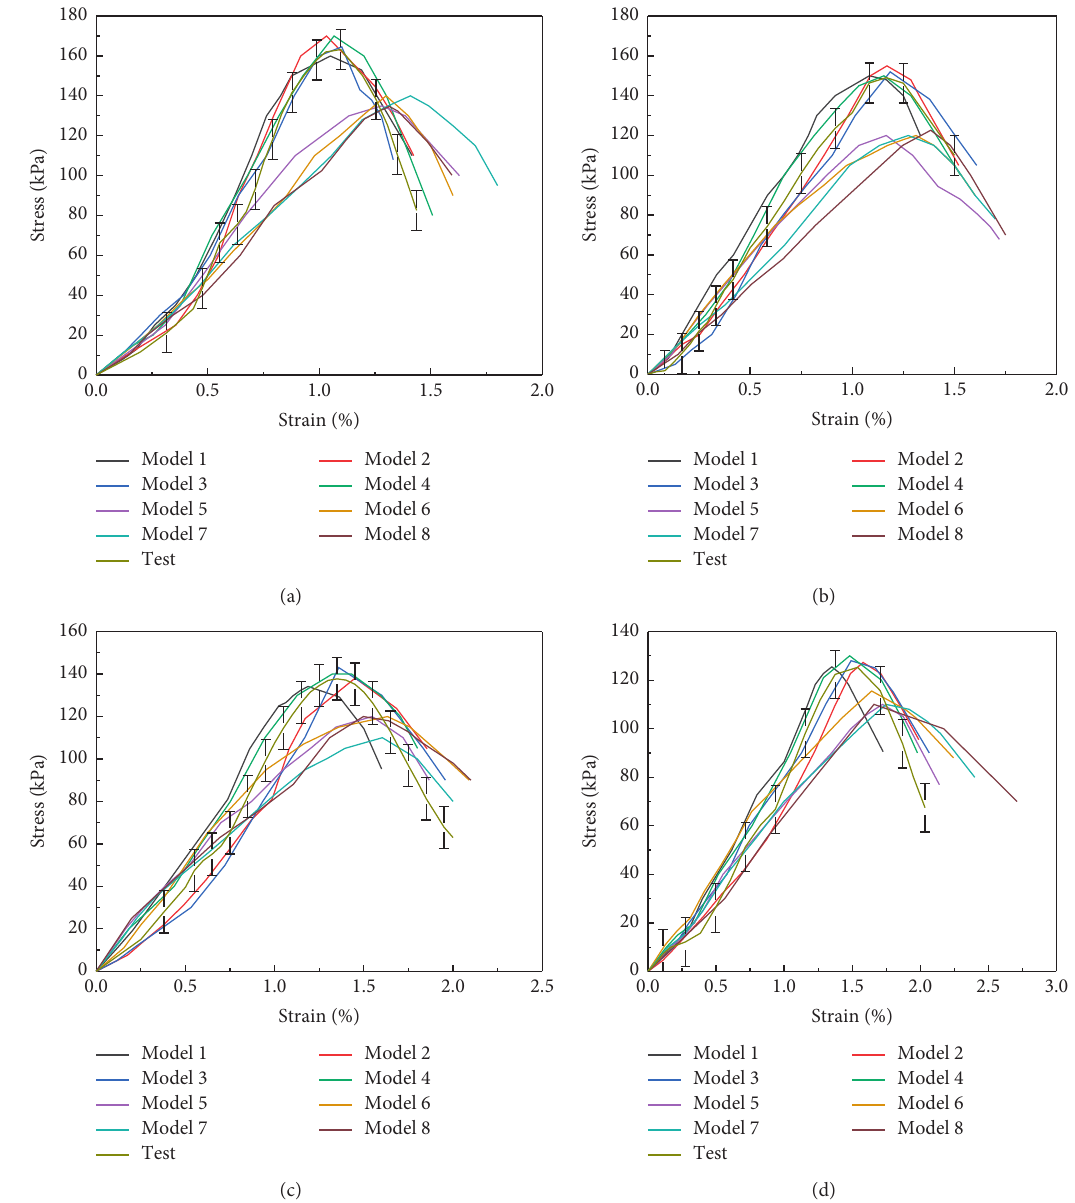
Figure 13: Stress-strain curves of macroscopic test and simulation: (a) moisture content 10%, (b) moisture content 12%, (c) moisture content 14%, and (d) moisture content